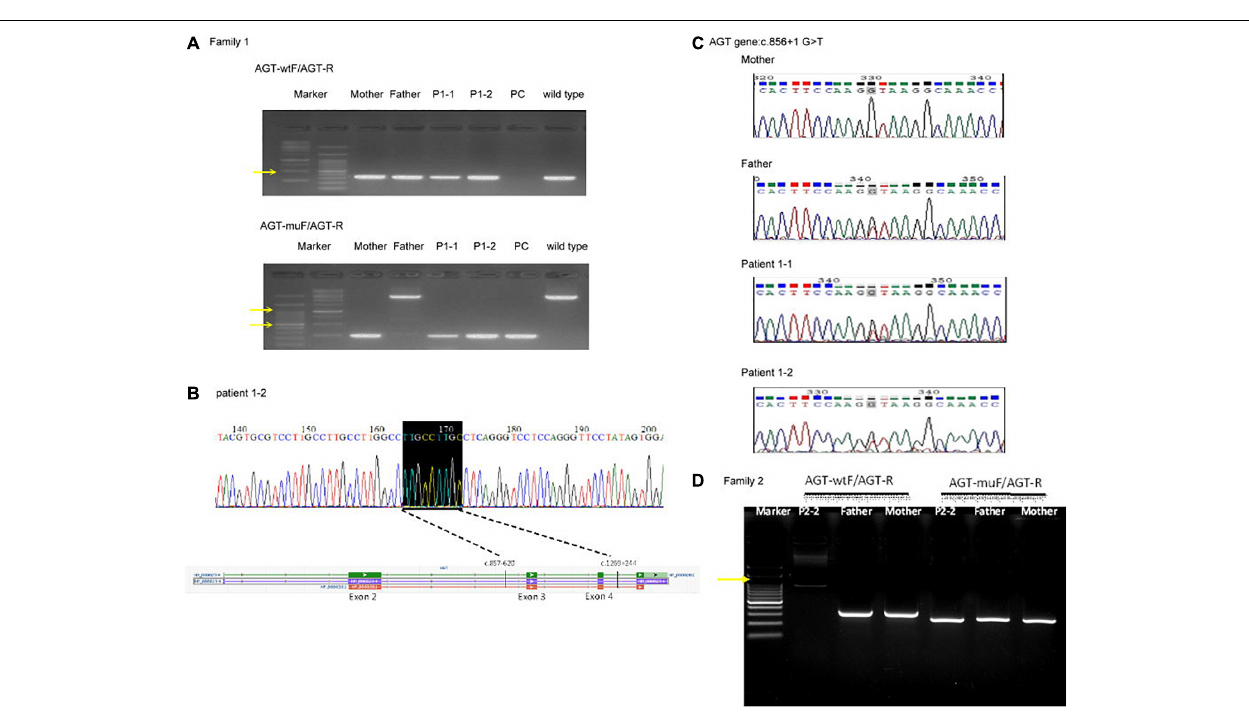
FIGURE 4 | Genomic DNA analysis of the reported deletion in the Taiwanese population using primers as previously reported (Ma et al., 2019). (A) Genomic DNA analysis of family 1. AGT -wtF/ AGT -R produced wild-type products (343 bp). AGT -muF/ AGT -R yielded a 250 bp product for c.857-619_1269 + 243delinsTTGCCTTGC and an ∼ 3,000 bp product for the wild type. The result indicates that the father has a wild-type allele and the proband and mother are heterozygous for this mutation. Yellow arrows indicate 1,000 and 500 bp size markers. (B) Sequencing of the AGT -muF/ AGT -R mutant